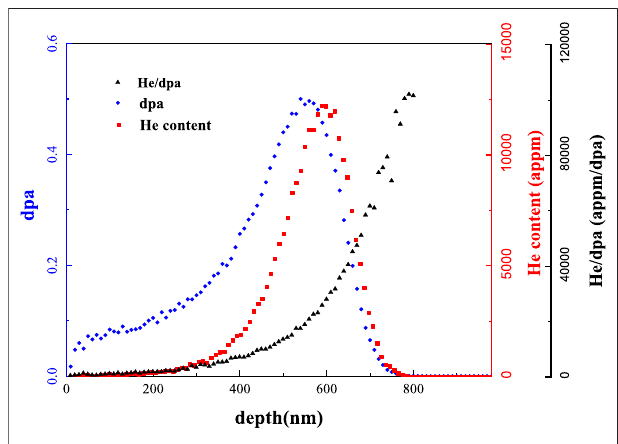
FIGURE 1 | The pro fi le of dpa, He content, and the He/dpa ratio calculated for Fe-9Cr alloy irradiated with 240 keV He 2+ ion by using SRIM